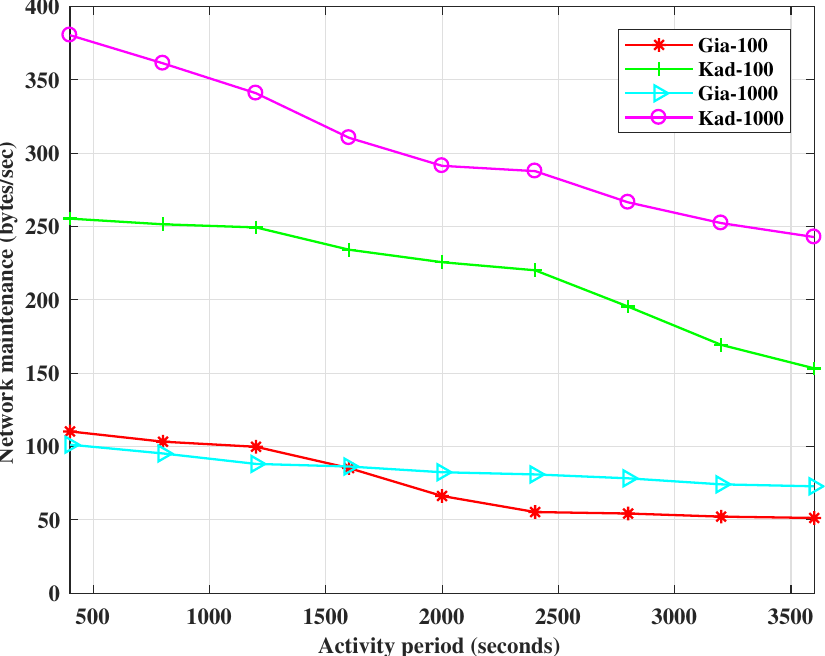
Figure 5. Performance comparison of bandwidth cost to maintain a typical P2P network using structured (Kademlia) and unstructured (Gia) P2P communication